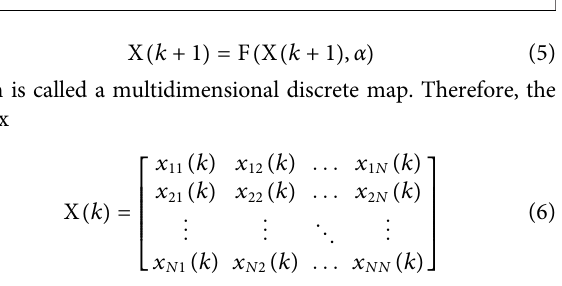
FIGURE 3 | Bifurcation diagram of the Henon map in Eq. 4 with respect to a . Other parameters: b = 0.3.